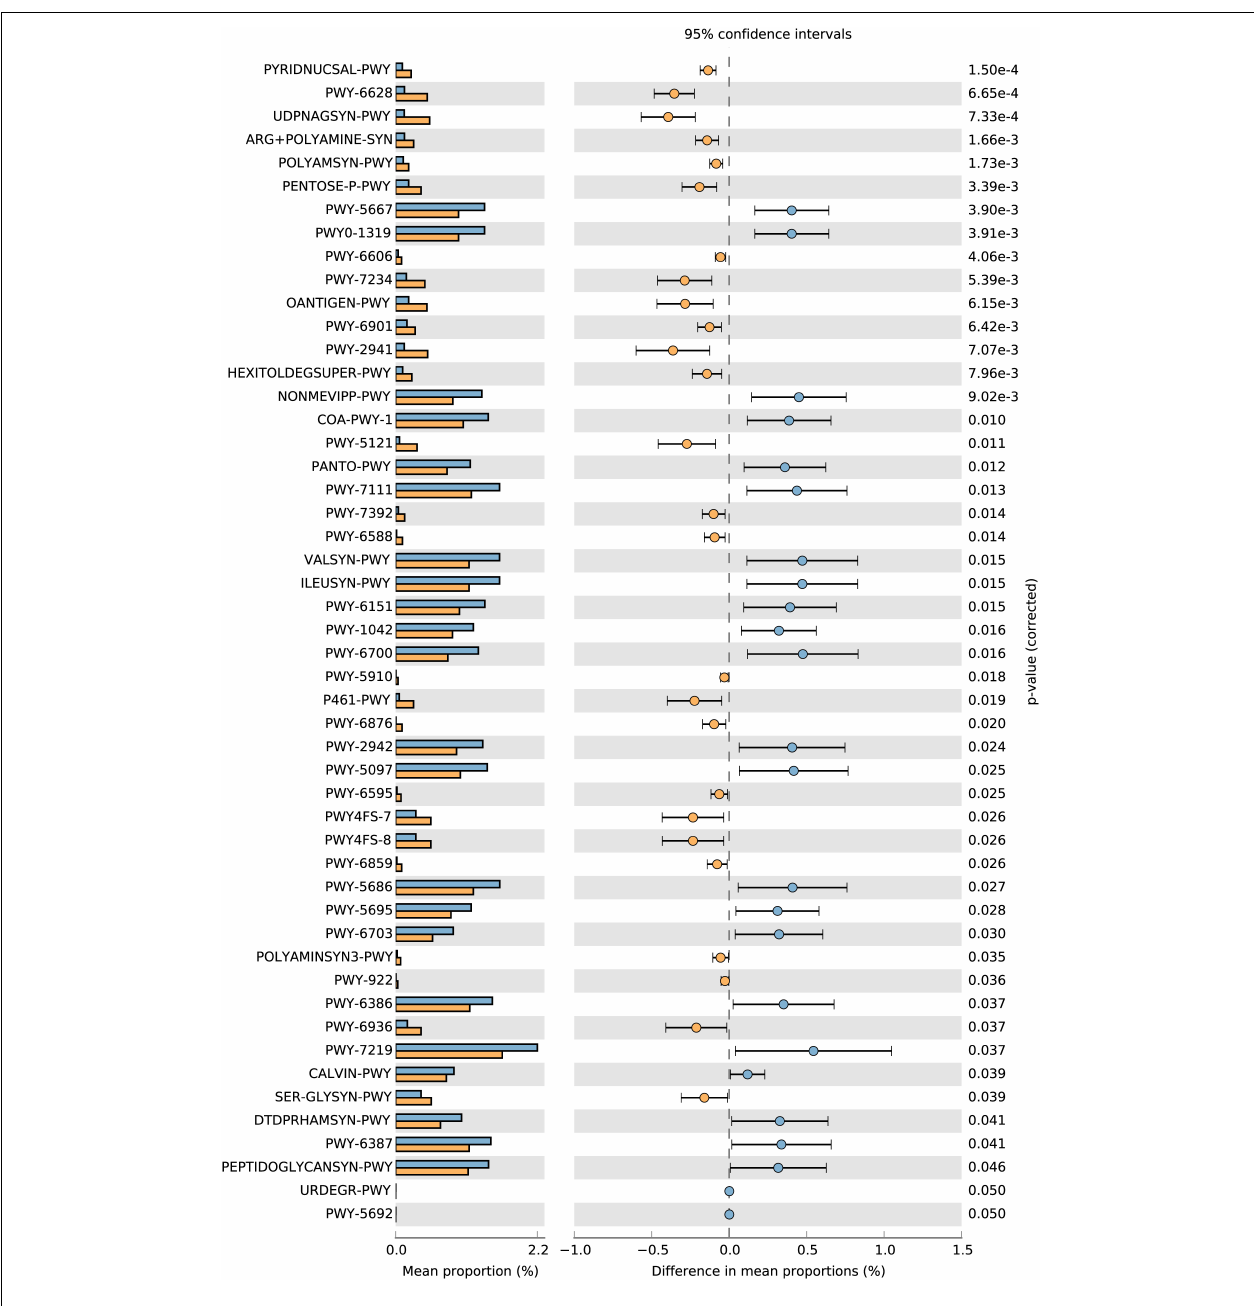
FIGURE 2 | Extended error bar plots showing the abundance of pathways differing significantly between days 0 and 30 in the 5-FU group. Corrected p -values are shown on the right. Adjusted p < 0.05 was considered significant. The yellow color stands for day 30 and blue for day